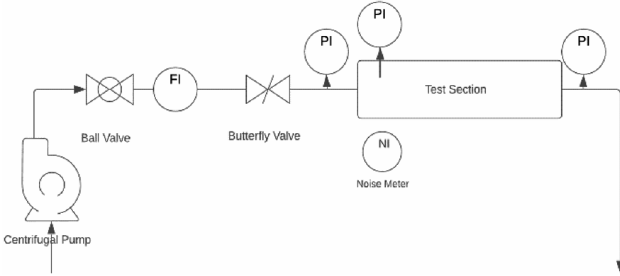
Fig. 2. The piping and instrumentation diagram of the experimental process.